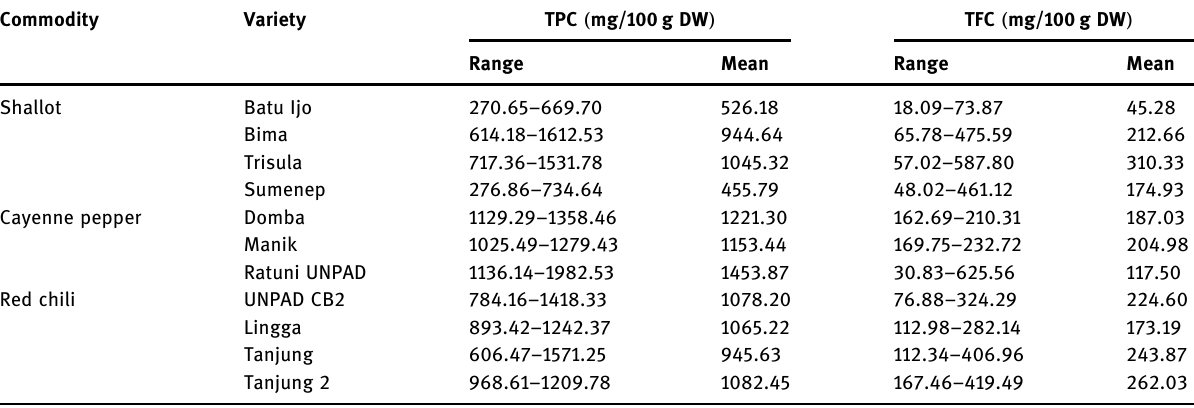
Table 1: Wet chemistry data of total phenolic ( TPC ) and fl avonoid content ( TFC ) derived from several horticultural products